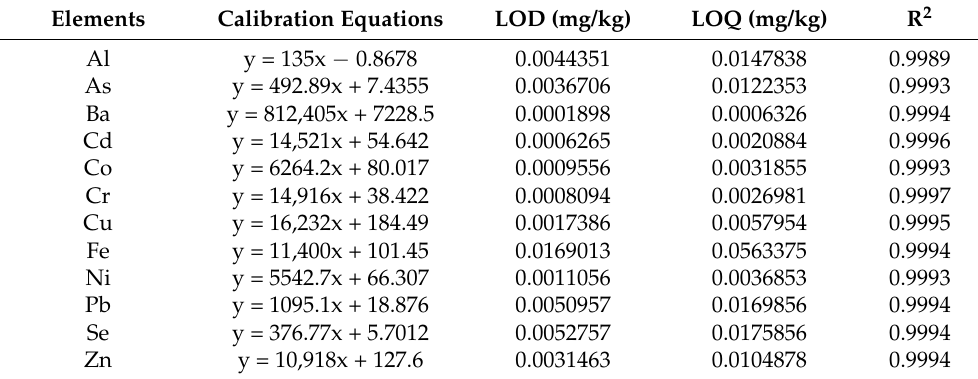
Table 3. Elements, calibration equations (y = ax + b) *, limits of detection (LOD), limits of quantifica- tion (LOQ), and correlation coefficients (R 2 ) obtained by external